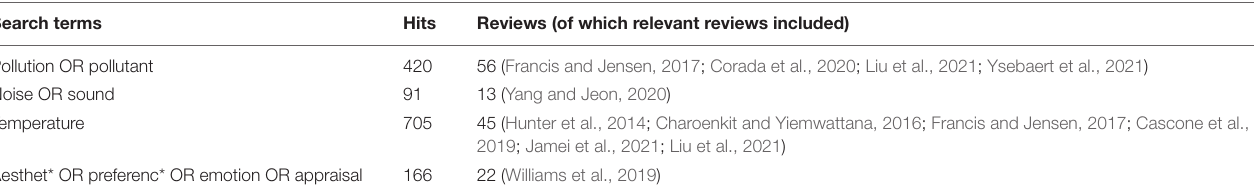
TABLE 1 | Results of the second structured literature in terms of number of articles identified for each search string, number of review papers within the total, and reviews considered relevant for our analysis. Search